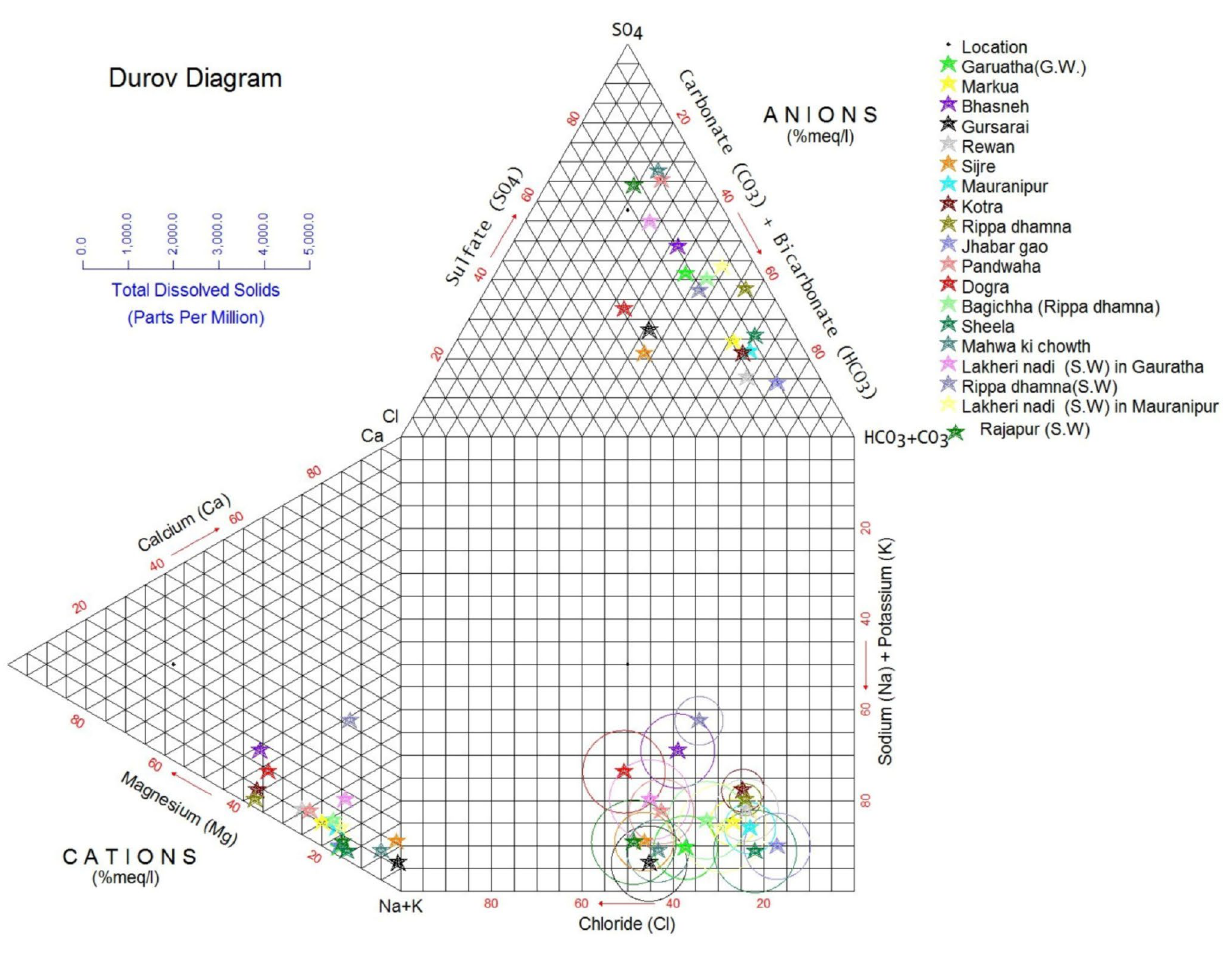
Fig. 7 Durov diagram of water samples